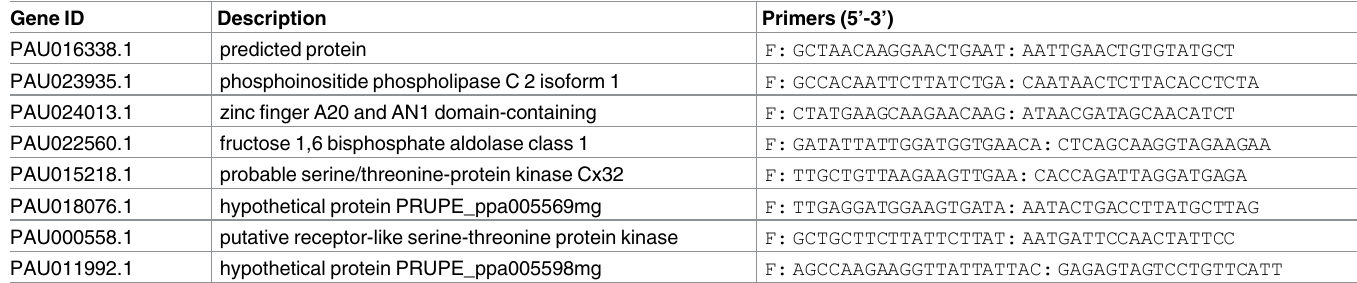
Table 1. Primers of qRT-PCR for validation of the selected